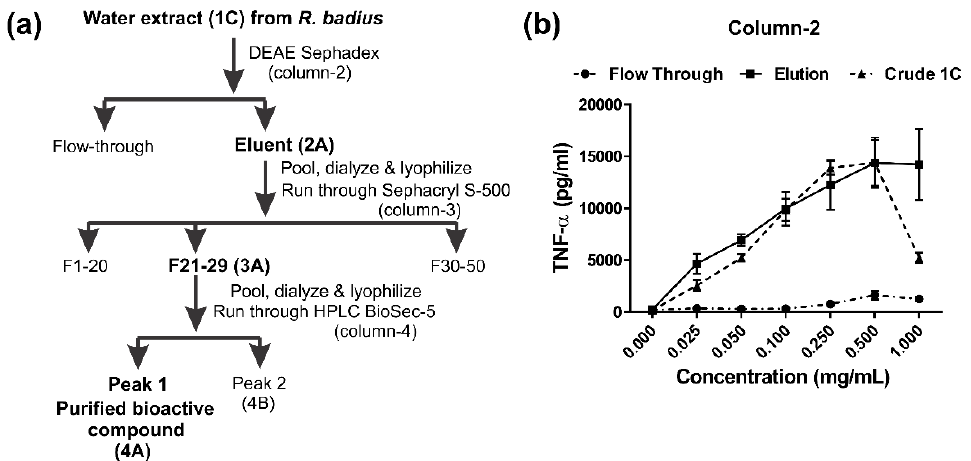
Figure 2. Purification of IMPP-Rb from R. badius . ( a ) Summary of the purification scheme used. ( b ) Purification using DEAE-Sephadex (column 2). Flow-through and eluent (post- 1 M NaCl) from a 750 mL DEAE column were pooled, dialyzed, and lyophilized. Various concentrations of samples were assessed for immunomodulatory activity, as indicated. Results shown are representative of two separate experiments.